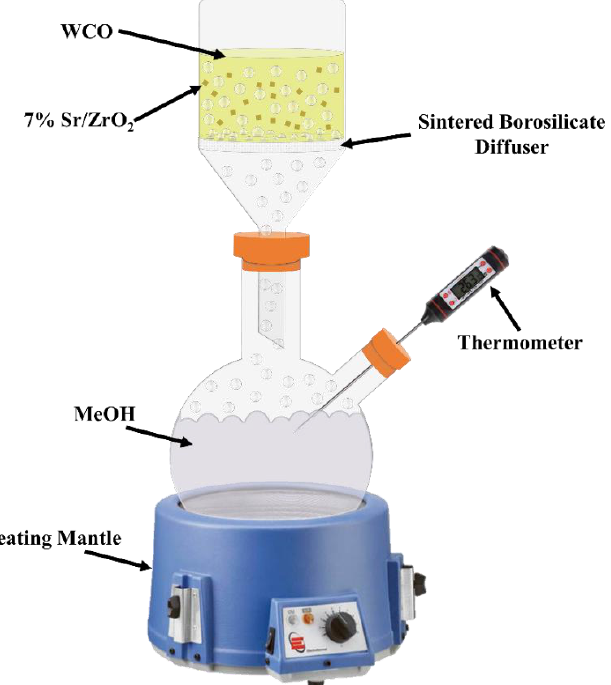
Figure 1. Systematic diagram of microbubble technology for biodiesel production.